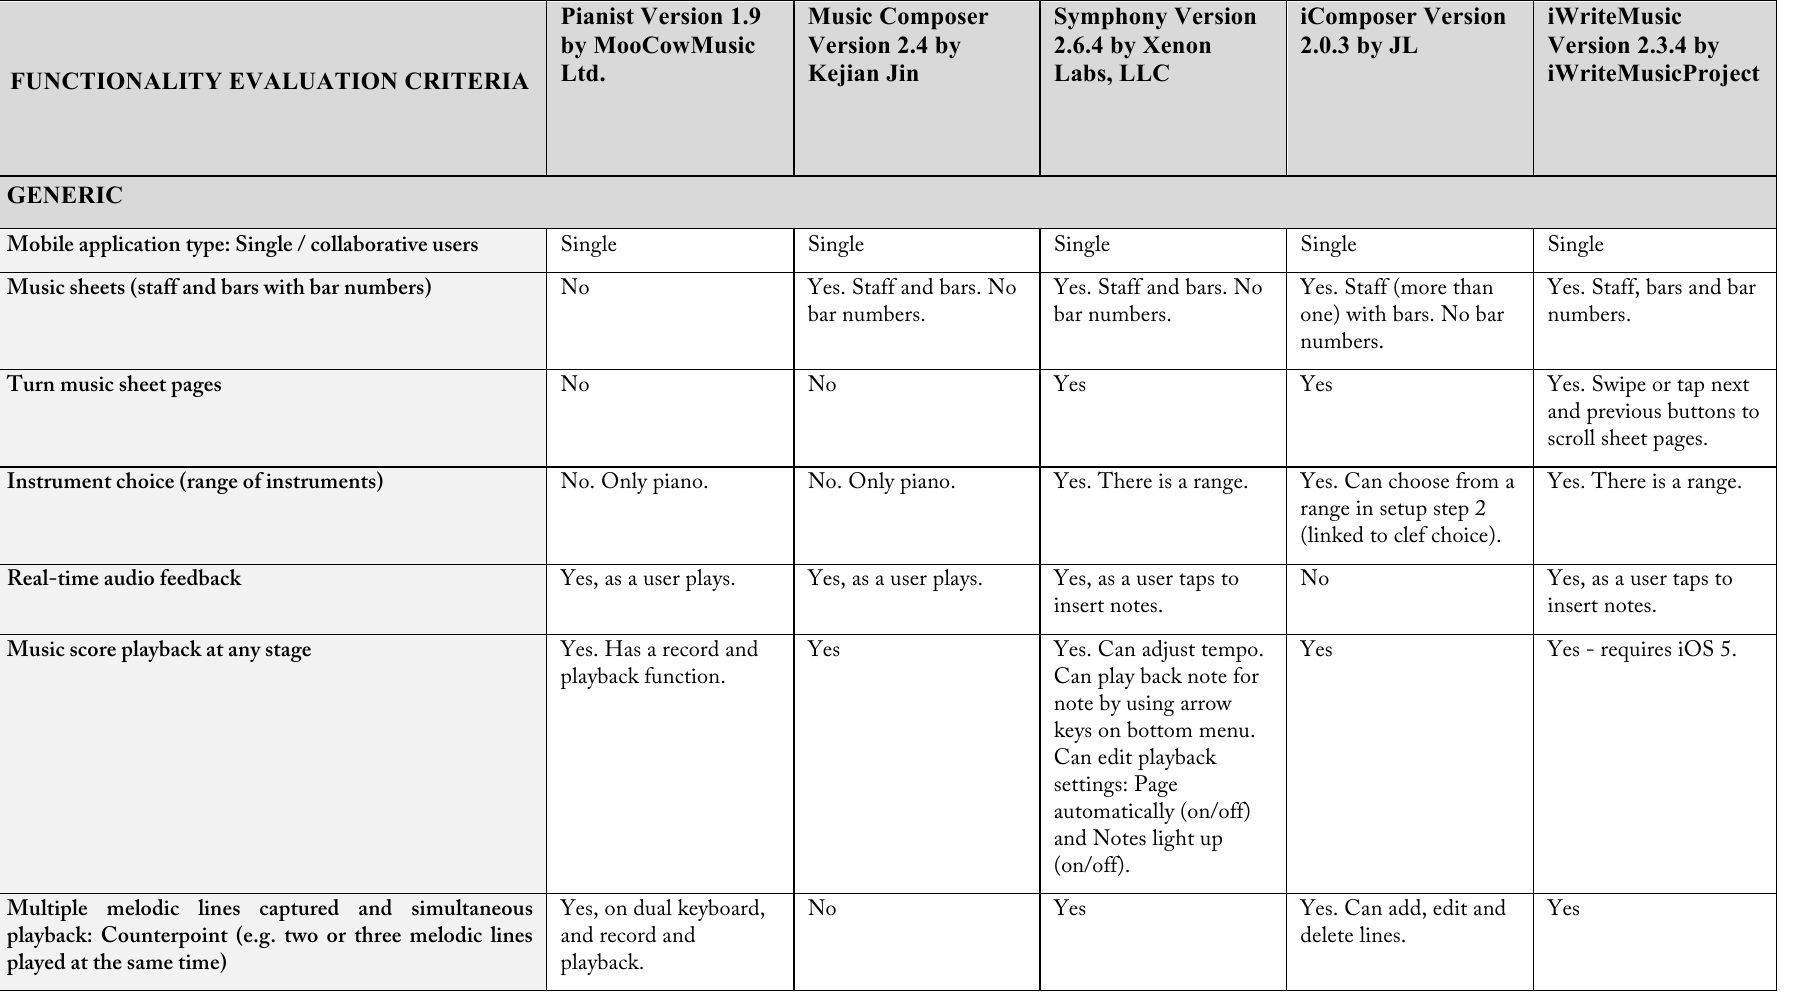
Table 5.2: A framework to evaluate mobile application functionality for music composition (applications 6-10)